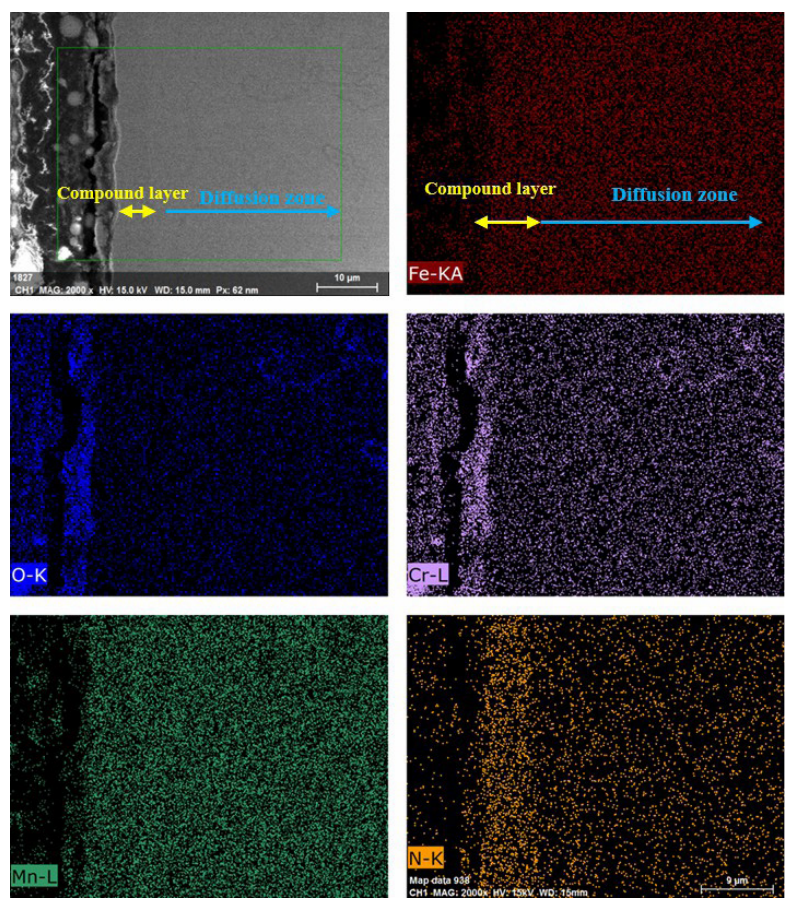
Figure 4. EDS elemental mapping scan along the cross-section of the nitrided layer of the CPN